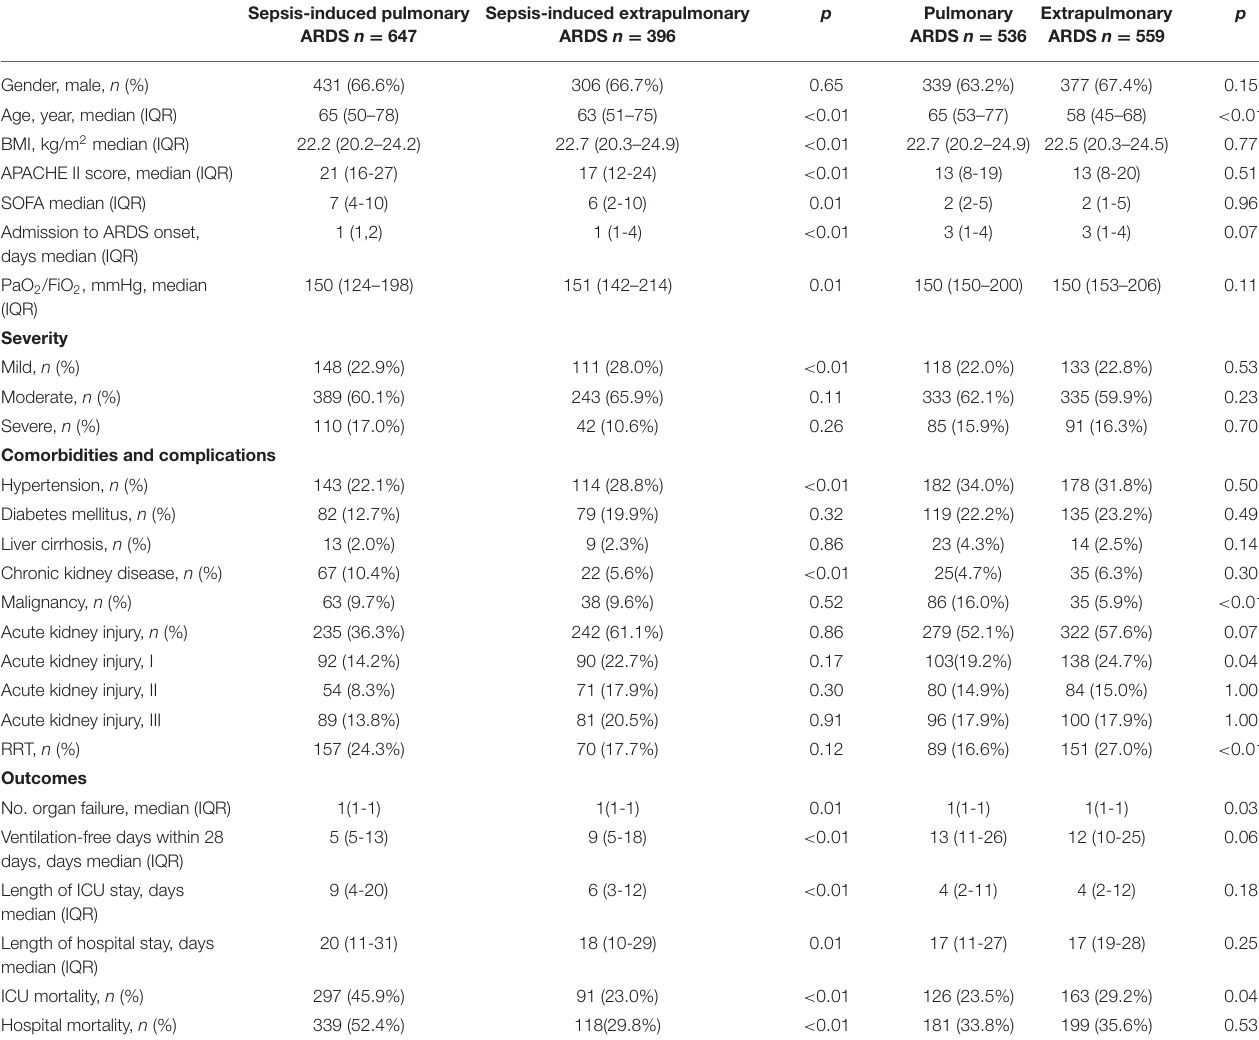
TABLE 1 | Baseline characteristics of ARDS patients among